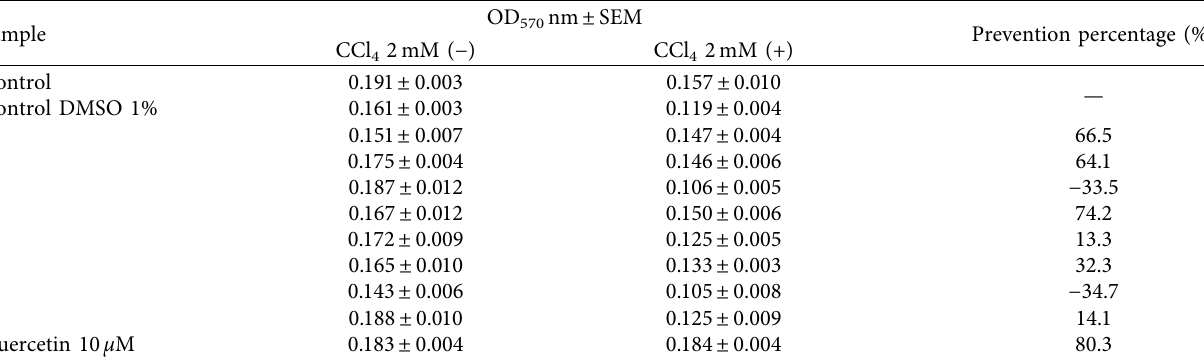
(Table 5) using HepG2 cell line of all separated compounds 1–8 were measured by MTT assay.